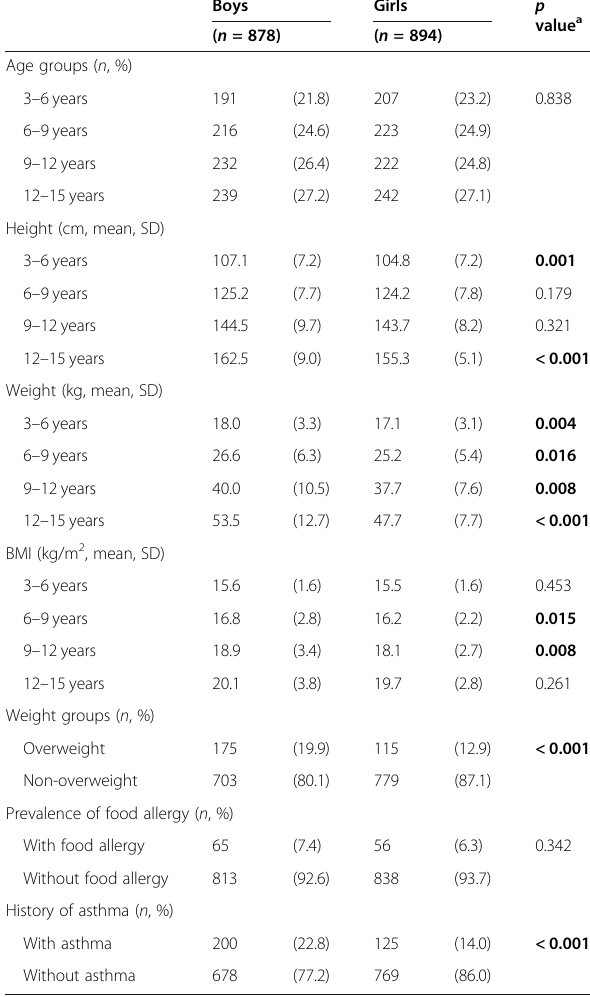
Table 1 General characteristics of participants Boys